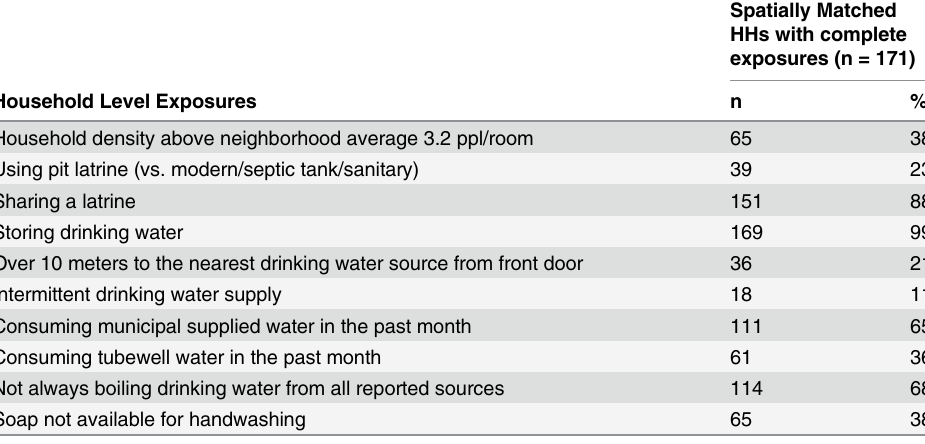
Spatially Matched HHs with complete exposures (n = 171)